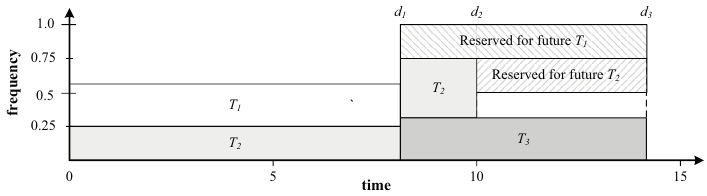
Figure 1. Example of a look-ahead earliest deadline first (EDF)